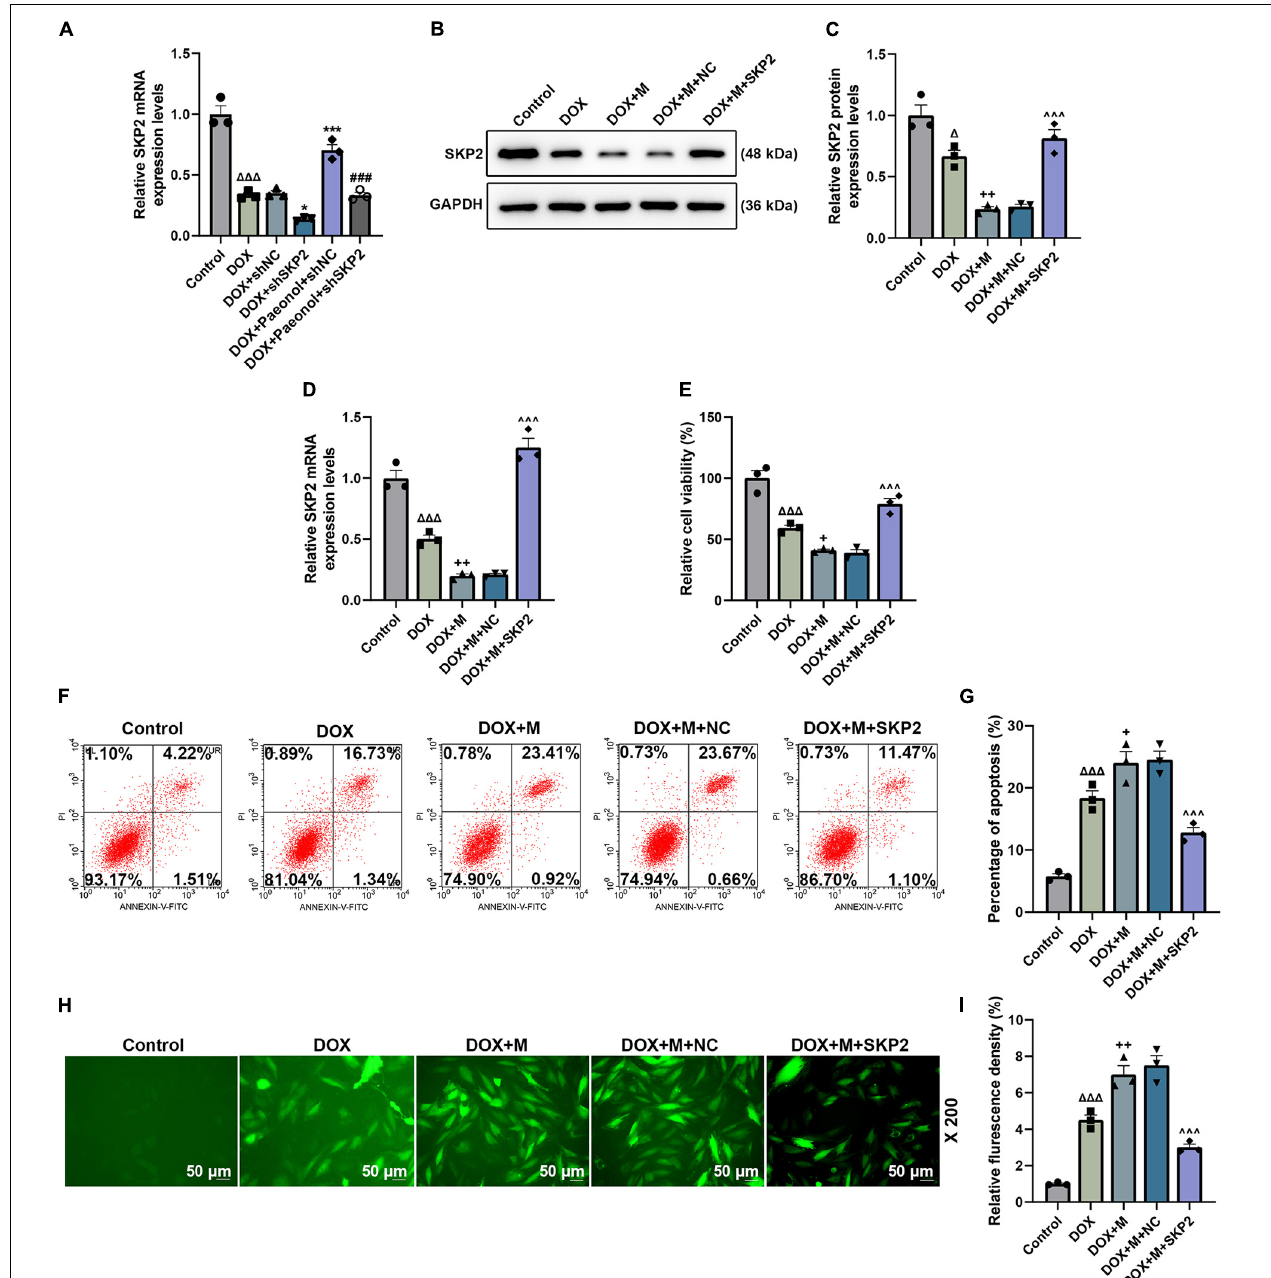
FIGURE 7 | (A) The expression of SKP2 in the miR-21-5p-treated DOX-induced H9c2 cells was calculated using RT-qPCR. GAPDH was used as an internal control. (B,C) The expression of SKP2 in the miR-21-5p-treated DOX-induced H9c2 cells was detected by western blot, where GAPDH was used as an internal control. (D) The levle of SKP2 in the miR-21-5p-treated DOX-induced H9c2 cells was calculated using RT-qPCR. GAPDH was used as an internal control. (E) The viability of the miR-21-5p-treated DOX-induced H9c2 cells was evaluated based on CCK-8 assays. (F,G) The apoptosis of the miR-21-5p-treated DOX-induced H9c2 cells was determined by flow cytometry. (H,I) The ROS of the miR-21-5p-treated DOX-induced H9c2 cells was observable following the H2DCFDA staining (Magnification: ’200). ( (cid:49) P < 0.05, (cid:49)(cid:49)(cid:49) P < 0.001 vs. Control; * P < 0.05, *** P < 0.001 vs. DOX+shNC; ### P < 0.001, vs. DOX+Paeonol+shNC; + P < 0.05, ++ P < 0.01 vs. DOX; ∧∧∧ P < 0.001, vs. DOX+M+NC). (DOX, doxorubicin; ROS, reactive oxygen species; M, miR-21-5p mimic; NC, negative control).